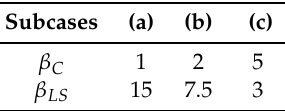
Table 1. Dimensionless geometric parameters related the investigated subcases: H =10 [mm], β C = B / H and β LS = L / max ( B , H )